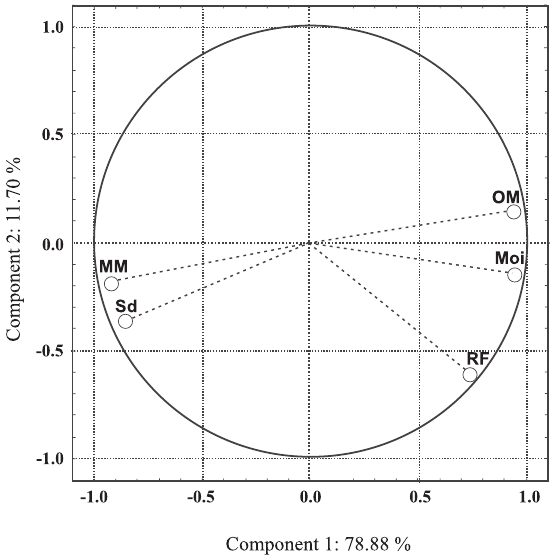
figure 3. correlation circle of variables measured in the principle component analysis - rubbed fiber (rf), soil density (sd), mineral material (MM), and moisture (Moi), organic matter